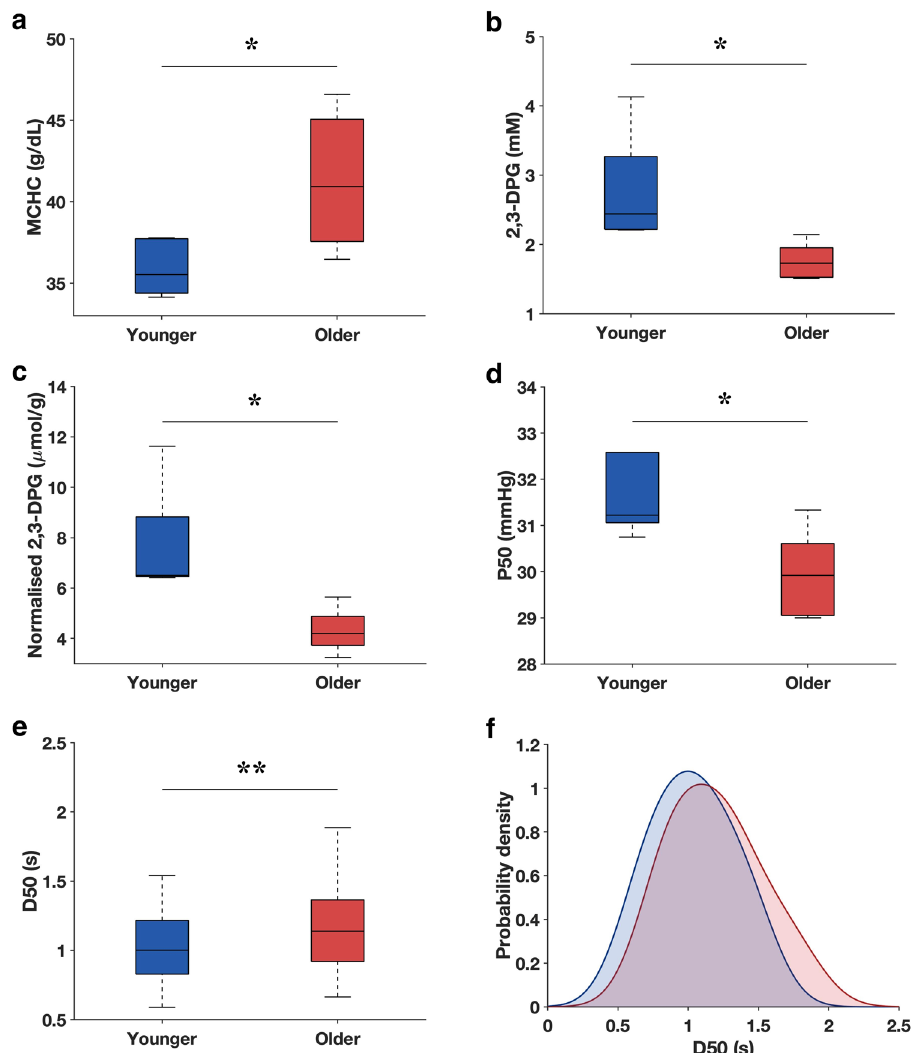
Fig. 2 Effect of in vivo aging on the O 2 af fi nity and release rate of RBCs. a – d MCHC, absolute 2,3-DPG concentration, normalized 2,3-DPG, and P50 of younger and older RBC samples ( n = 5 of biologically independent samples). e D50 of younger and older RBCs. Older RBCs ( n = 89 of biologically independent RBCs) showed a higher D50 than younger RBCs ( n = 93 of biologically independent RBCs). f Probability density functions of D50 for younger (blue) and older (red) RBCs. It should be noted that results in ( a – d ) are based on bulk sample measurements, whereas those in ( e , f ) on single-cell measurements using the MAP. * P < 0.05, ** P < 0.005. The central mark of the boxplot indicates the median, and the bottom and top edges of the box indicate the 25th and 75th percentiles, respectively. The whiskers extend to the most extreme data points not considered